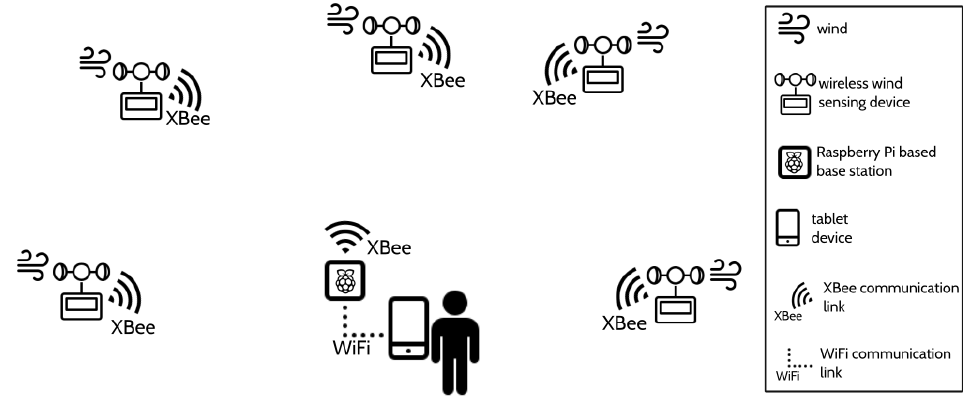
Figure 1. The wind data-acquisition system (icons from